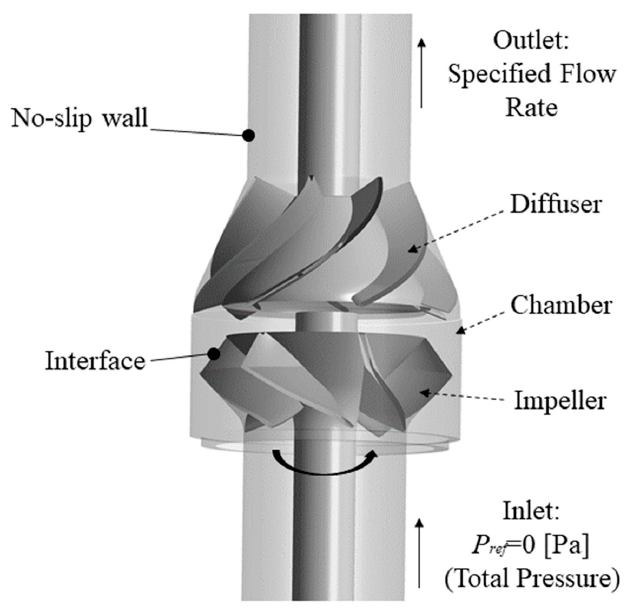
Figure 4. Computational domain model and boundary conditions.